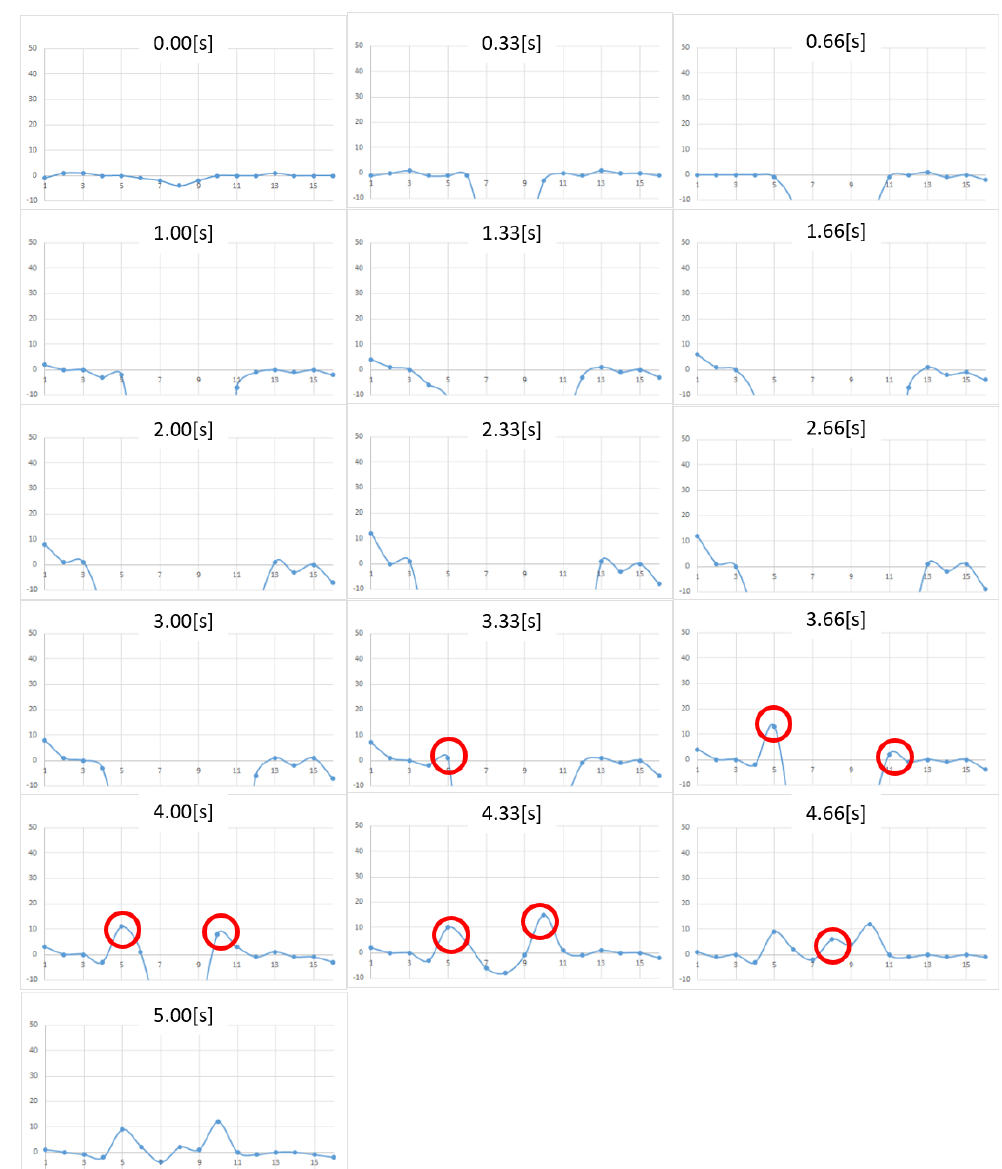
Figure 14. Change in pressure distribution for shaving gel. The vertical axis represents the force (in milli newton). The horizontal plane represents the location of the sensing point.